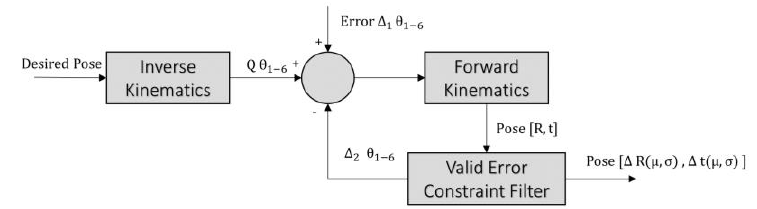
Figure 5. Flowchart of the orientation noise modelling approach .